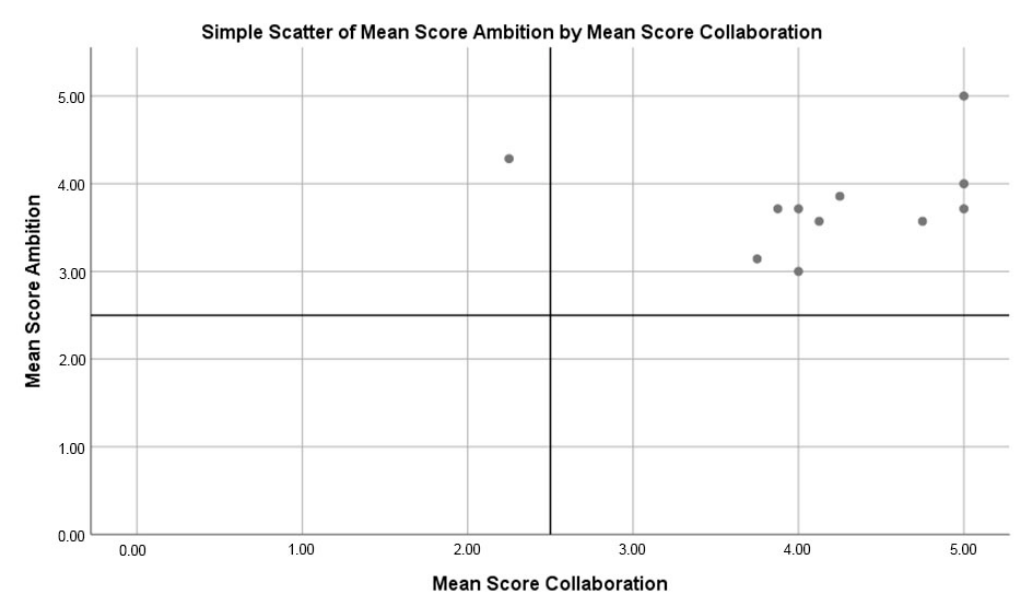
Figure 3. Scatterplot of cooperatives by collaboration and ambition characteristics.